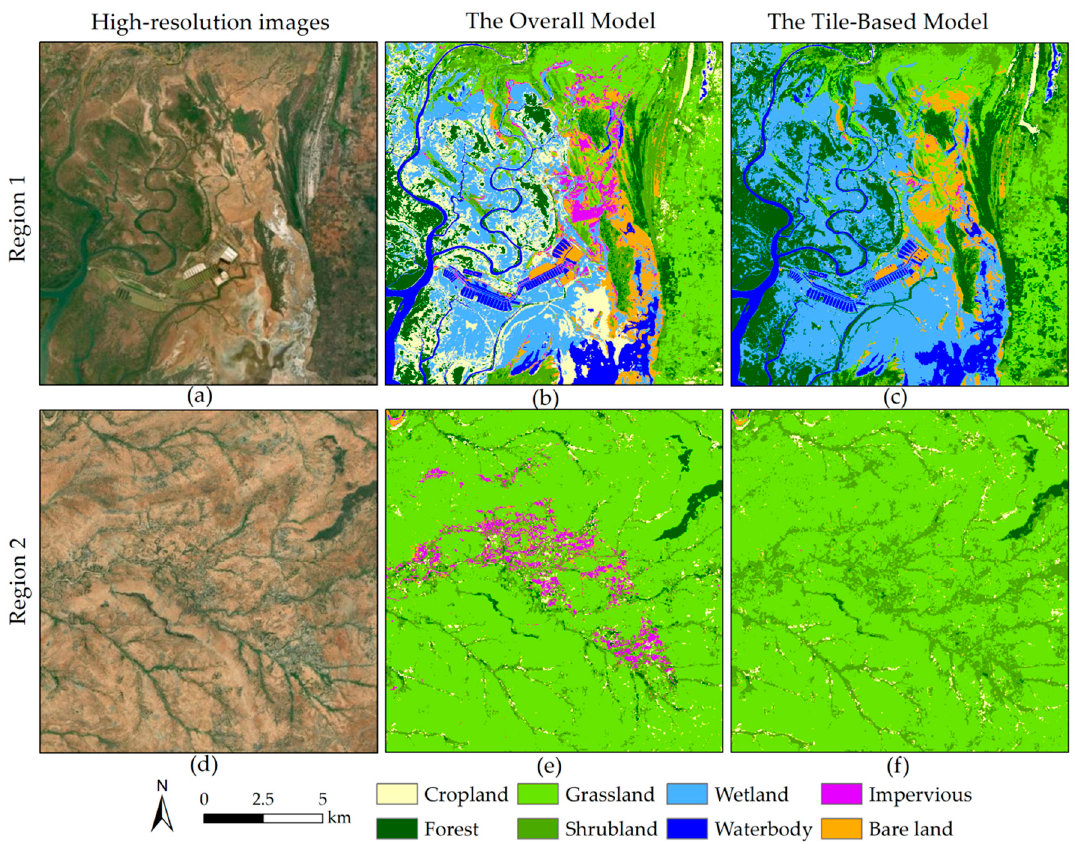
Figure 6. Examples of comparison of the classification performance using our proposed method (i.e., the tile-based model) ( c , f ) in this study and the conventional method (i.e., the overall model) ( b , e ). ( a , d ) are zoomed high-resolution images from Google Earth. Region 1 exhibits an improvement in the misclassification between cropland and wetland. Region 2 shows that the issue of impervious areas misclassification is improved.